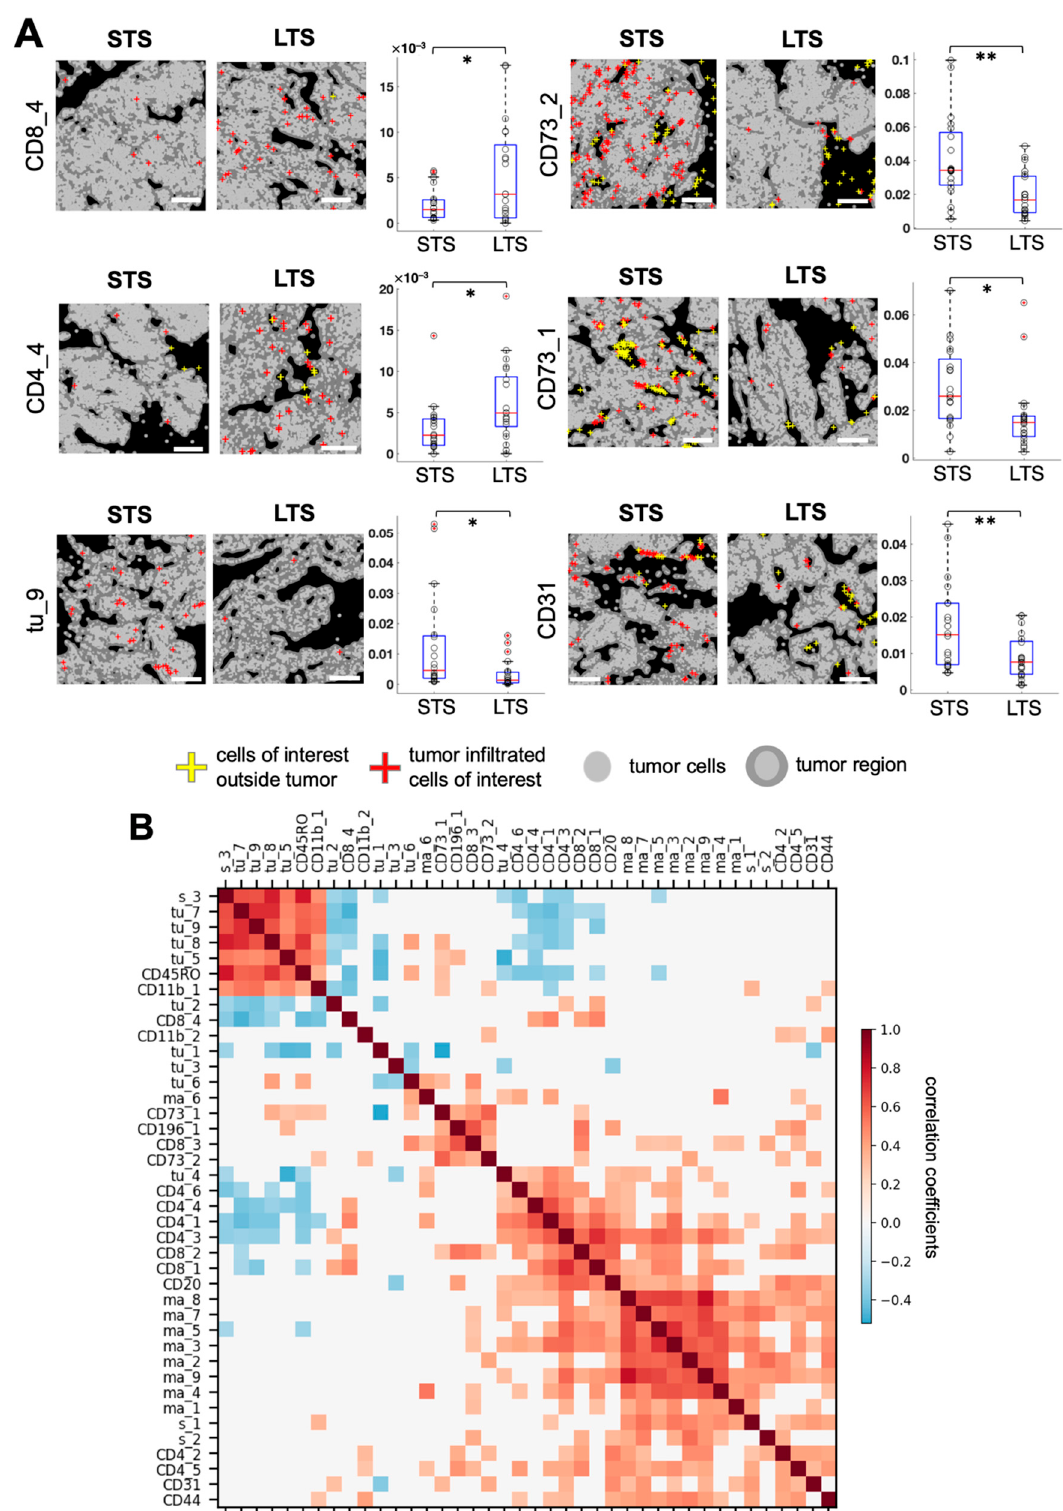
Figure 5. Identification of cell subtypes that exhibit density differences in tumor-enriched regions between long-term survivors (LTS) and short-term survivors (STS). ( A ). Left, visualization of the spatial distribution of tumor-infiltrated cells of interest in LTS and STS. White scale bar, 200 µ m. Right, comparison of cell counts in tumor-enriched regions per total tumor cells for each cell subtype of interest between LTS and STS ( n = 21 LTS, n = 20 STS, unpaired t test, * p < 0.05, ** p < 0.01). ( B ). Spearman correlation between cell densities of any two cell subtypes in the tumor-enriched regions. White color indicates correlation coefficient = 0 or p ≥ 0.05. Cell densities were ordered by hierarchical clustering with the Ward method.